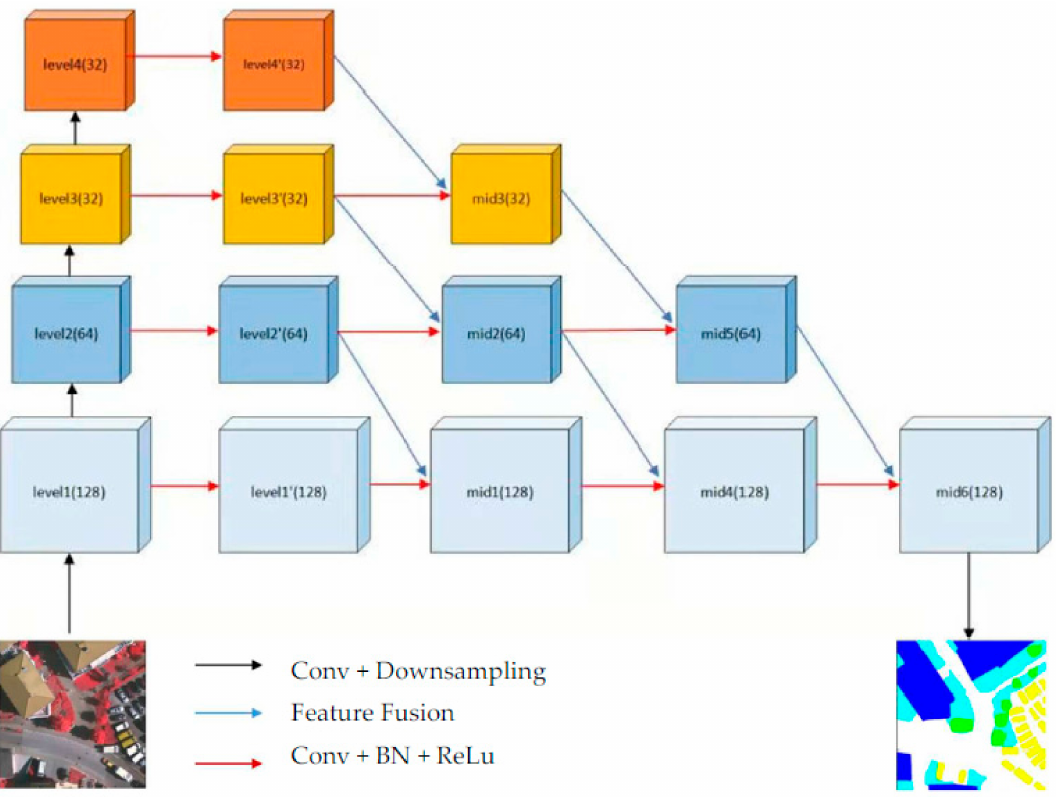
Figure 1. Architecture of MFNet.